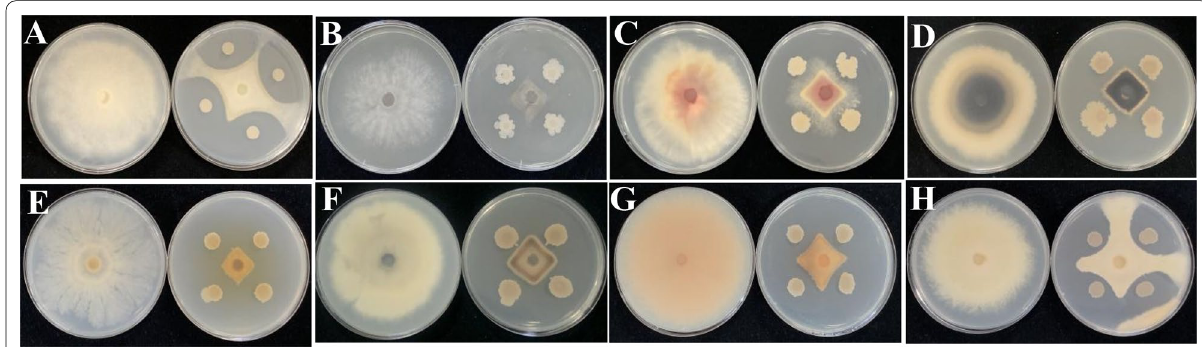
Fig. 3 Antimicrobial effects of Gxun-6 on other plant pathogenic fungi ( A – H are the antagonist effects of strain Gxun-6 on C. musae , B. dothidea , F. pseudograminearum , A. alternata , C. parasitica , C. fructicola , F. sacchari and F. commune )